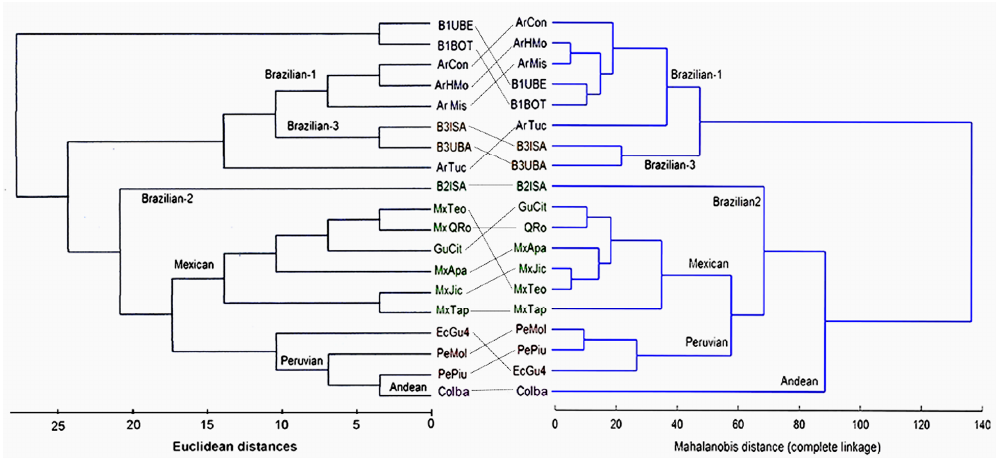
Figure 9. Dendrograms of the female wing shape and ITS1 sequences: (Right) UPGMA clustering of morphometric data based on the wing shapes of females from 19 population samples of the AF complex. (Left) UPGMA clustering of ITS1 sequences of the same populations. The names in the branches correspond to the morphotype classification.